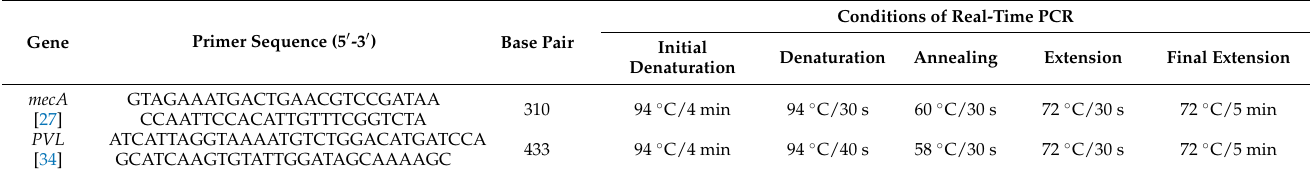
Table 1. Oligonucleotide primers and conditions of real-time PCR for running of mecA and PVL genes.